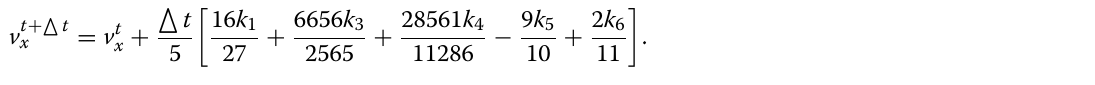
To verify the stability of the simulation model, we have checked the conservation of energy during all simulation runs. As an example, the trajectories of protons having (i) ◦ ◦ energy E k = 10 MeV , at L = 4 , α eq = 15 , ψ = 90 and ◦ ◦ (ii) energy E k = 10 MeV , at L = 4 , α eq = 50 , ψ = 90 are shown in Fig. 1a, b, respectively. Also, their respective energies, E k , estimated from the simulation at each time step are plotted as a function of time in Fig. 1c, d, respec- tively. The three-dimensional trajectories of both protons in the dipolar magnetic field are evident in Fig. 1a, b. As expected, its motion is helical around the magnetic field lines. In addition to this, it performs bounce and azi- muthal drift motions due to the gradient and curvature of the magnetic field lines. Also, due to the charge depend- ency of ∇ B × B drift, the proton moves westward as shown by the black arrow. It is noticed that the latitudinal extent of the proton during its bounce motion is wider ◦ for the proton with α eq = 15 (see Fig. 1a) as compared (cid:31) ◦ to the proton with α eq = 50 (see Fig. 1b). Here, m1 and (cid:31) m2 can be considered as magnetic latitudes of two mir- ror points of the proton in southern and northern hemi- (cid:31) (cid:31) (cid:31) spheres. The mirror point latitudes ( m1 = m2 = m